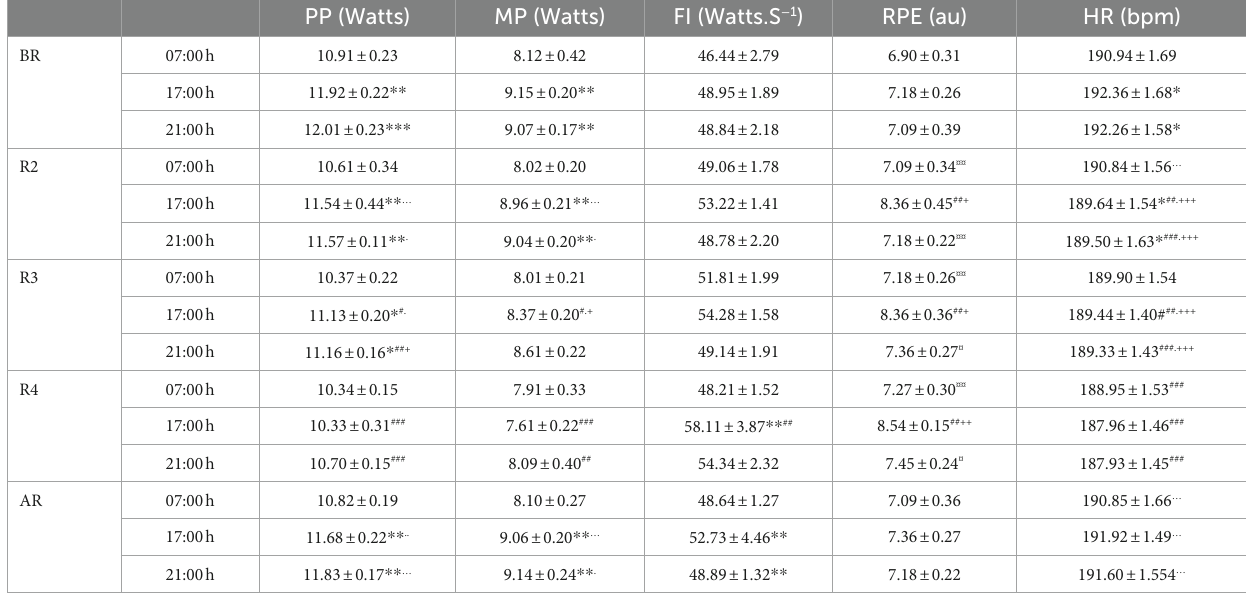
TABLE 5 Values (mean ± SD) of Wingate scores [Peak power (PP), Mean power (MP), and fatigue index (FI)], heart rate (HR) and rating of perceived exertion scores (RPE) registered during the three times of the day (07:00, 17:00, and 21:00 h) before Ramadan (BR), the second week of Ramadan (R2), the third week of Ramadan (R3), the fourth week of Ramadan (R4) and after Ramadan (AR; n =